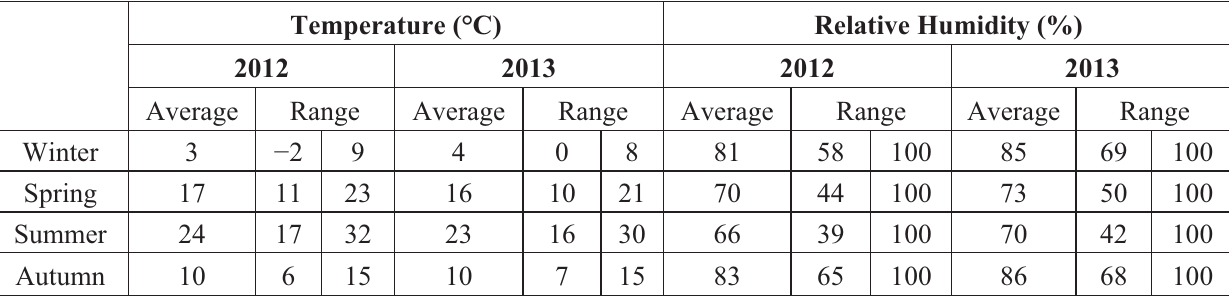
Table 1. Temperature (°C) and Relative Humidity (%) in the slaughterhouse area during 2012 and